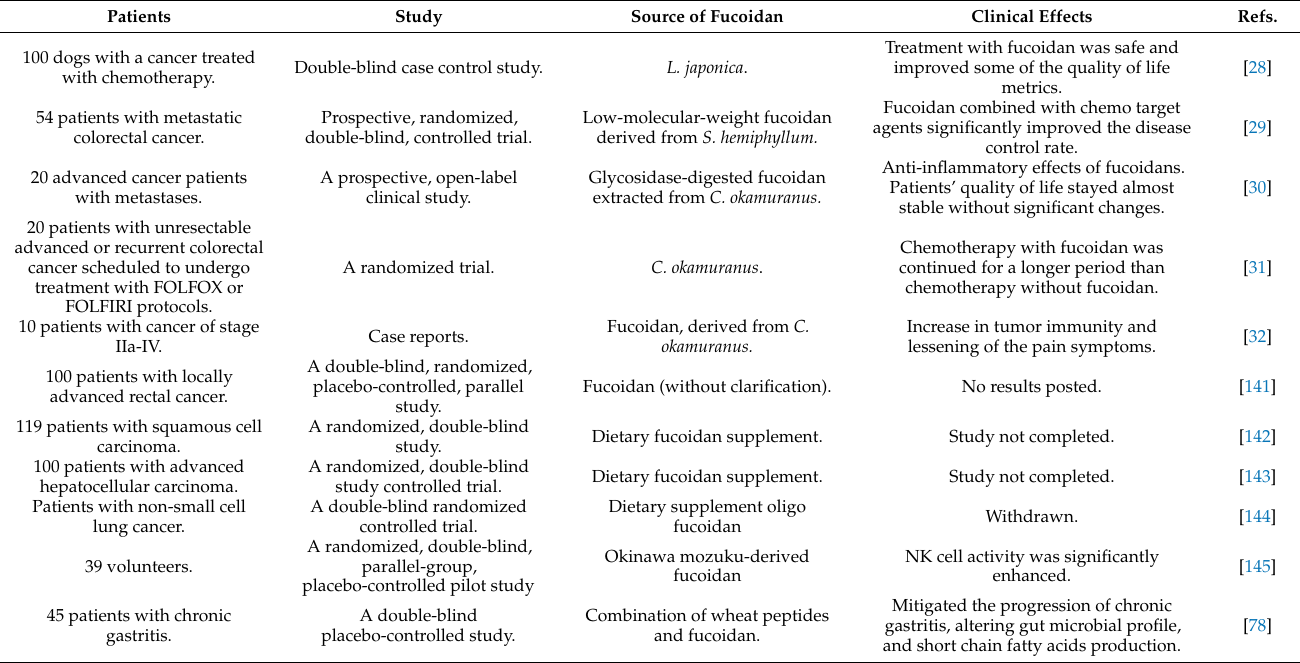
Table 2. Clinical trials with the use of